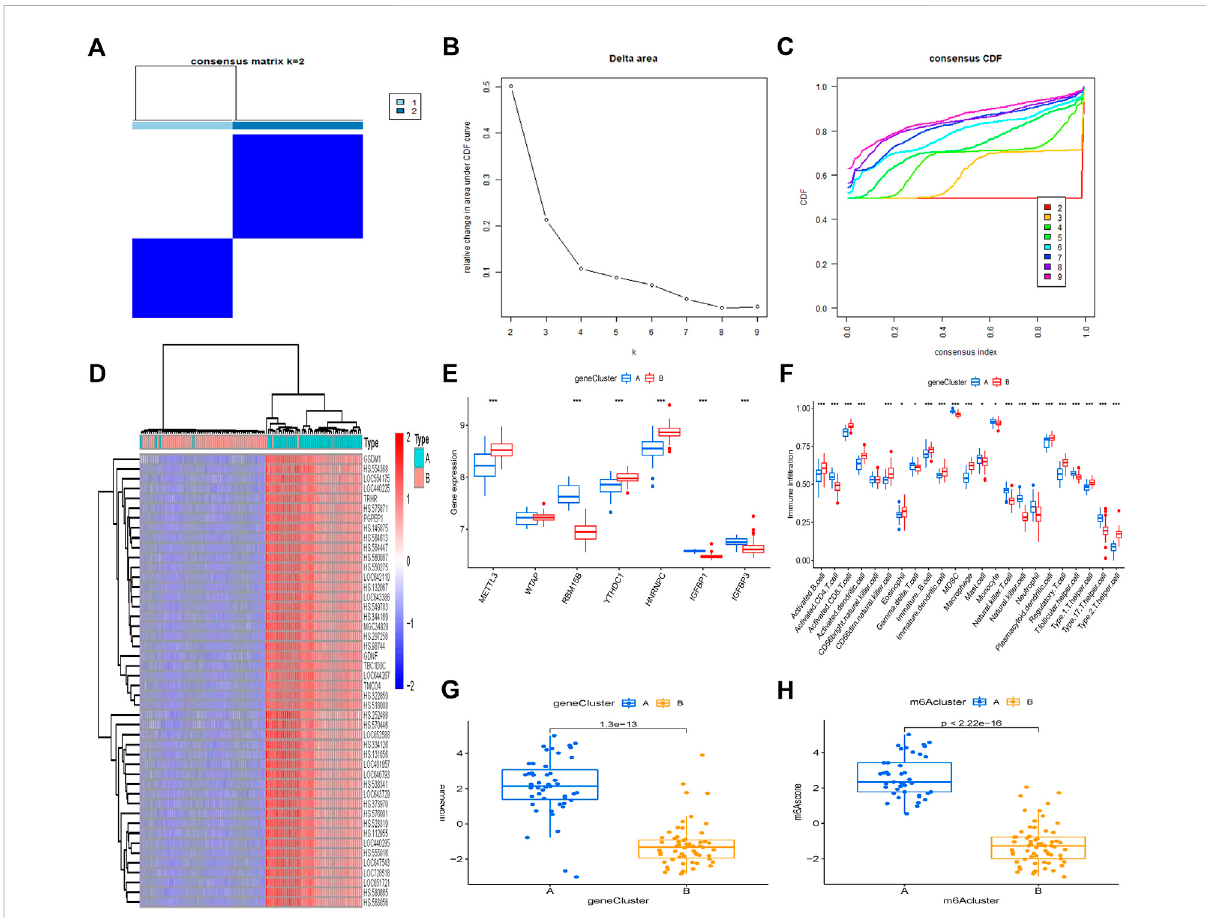
FIGURE 8 ClusteringoftheDEGsintwom 6 Aclustersbyconsensus. (A) For k = 2,consensusmatricesofthesevenmajorm 6 Aregulators. (B) Thedeltaarea difference for k = 2 – 9. (C) The CDF curve ’ s area under the curve. (D) Heatmap of DEG expression in gene clusters A and B. (E) Histogram showing differential expression of the seven major m 6 A regulators in gene clusters A and B. (F) Levels of immune cell in fi ltration in gene groups A and B. (G) M 6 A score differences between gene clusters A and B. (H) The m 6 A score differences between gene clusters A and B. * p < 0.05, ** p < 0.01, and *** p <